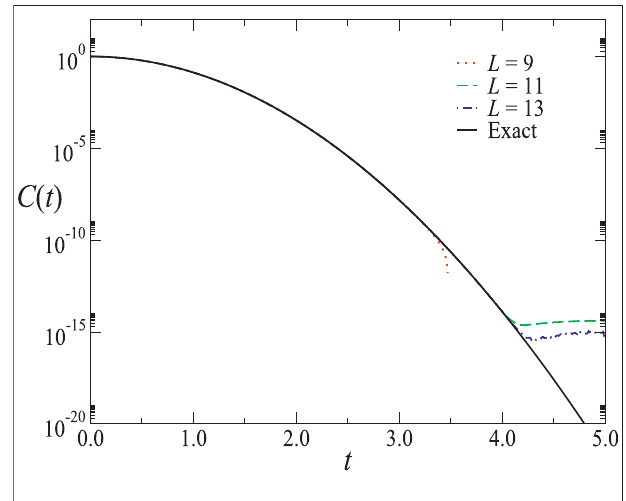
FIGURE 1 | Time correlation function of a tagged spin in the TI model when B (cid:2) J (cid:2) 1 . 0 for some chain sizes L , as indicated. Here and in the next fi gures J (cid:2) 1 is the energy unit. The exact solution is a Gaussian, which lies underneath the L (cid:2) 13 curve. [Figure from Guimarães et al.